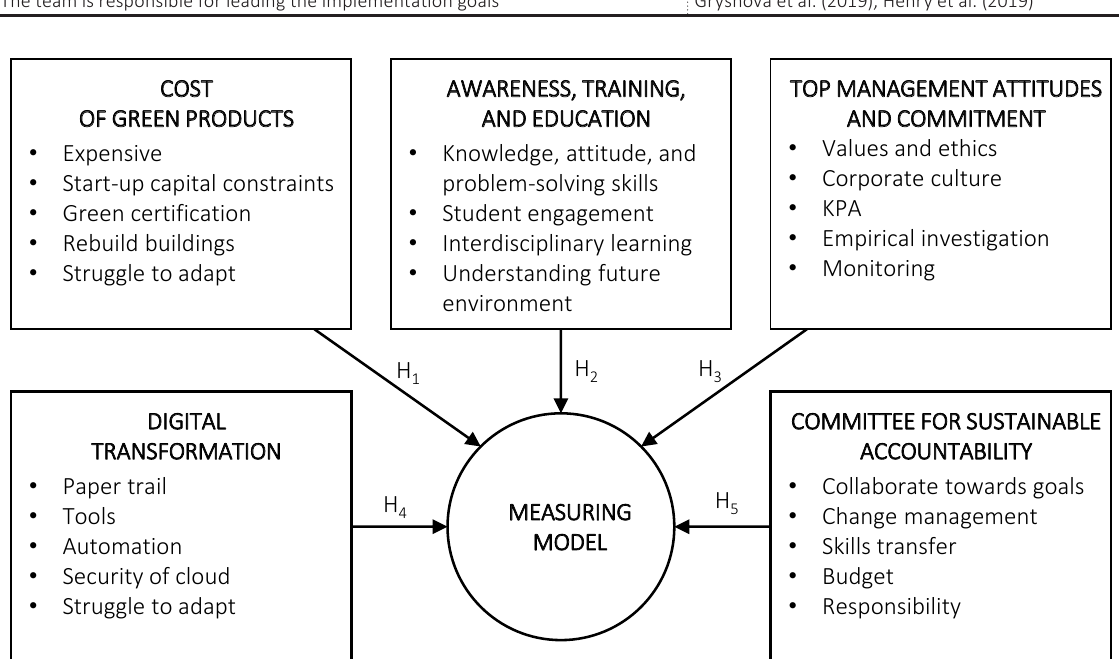
Figure 1. Conceptual model